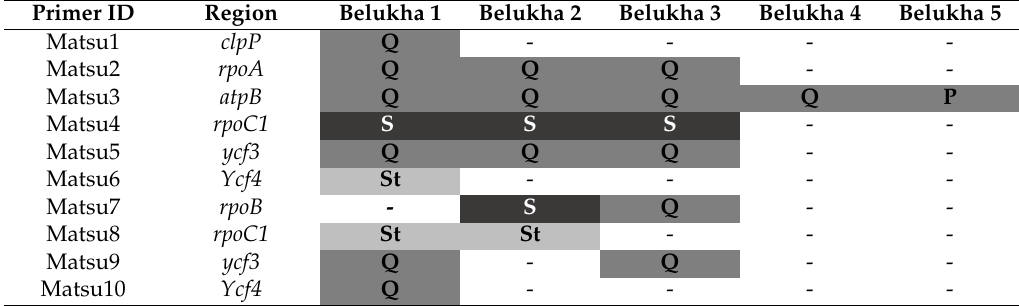
Table 3. Identification of pollen grains by multiplex PCR. Each pollen grain was identified at the subgenus, section, or subsection level based on regions that were positively amplified. The S, Q, P, and St indicate the subgenus Strobus , section Quinquefoliae , section Pinus , and subsection Strobus , respectively. Dashes indicate a lack of amplification. For the sequence data and identification procedures, see Supplementary data.